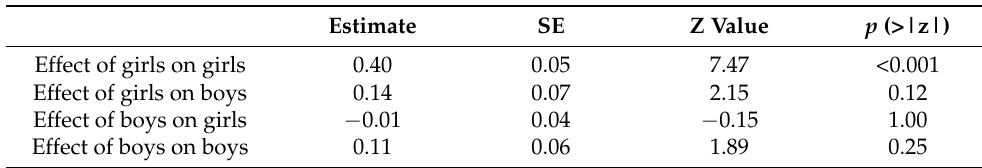
Table 2. Results of the linear mixed-effects models for the same-sex and opposite-sex peer interaction effects.